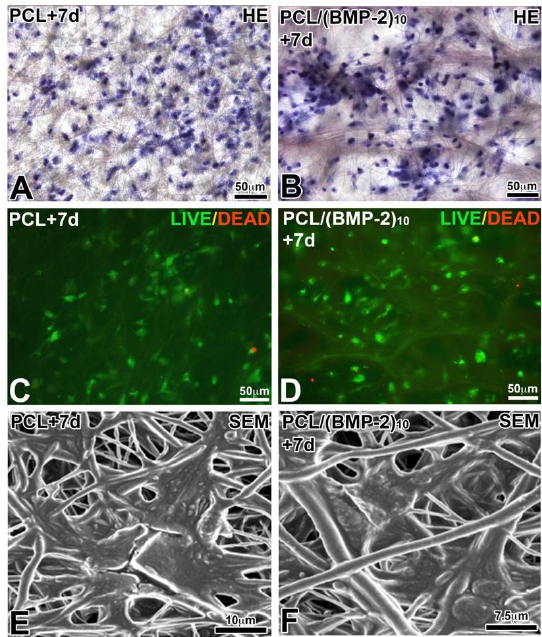
Figure 3. Biocompatibility of PCL and bioactive scaffold for hBM-MSCs after 7 days of culture. HE staining ( A , B ), LIVE/DEAD viability test ( C , D ) and SEM observation ( E , F ). PCL and BMP-2 were not toxic to hBM-MSCs.